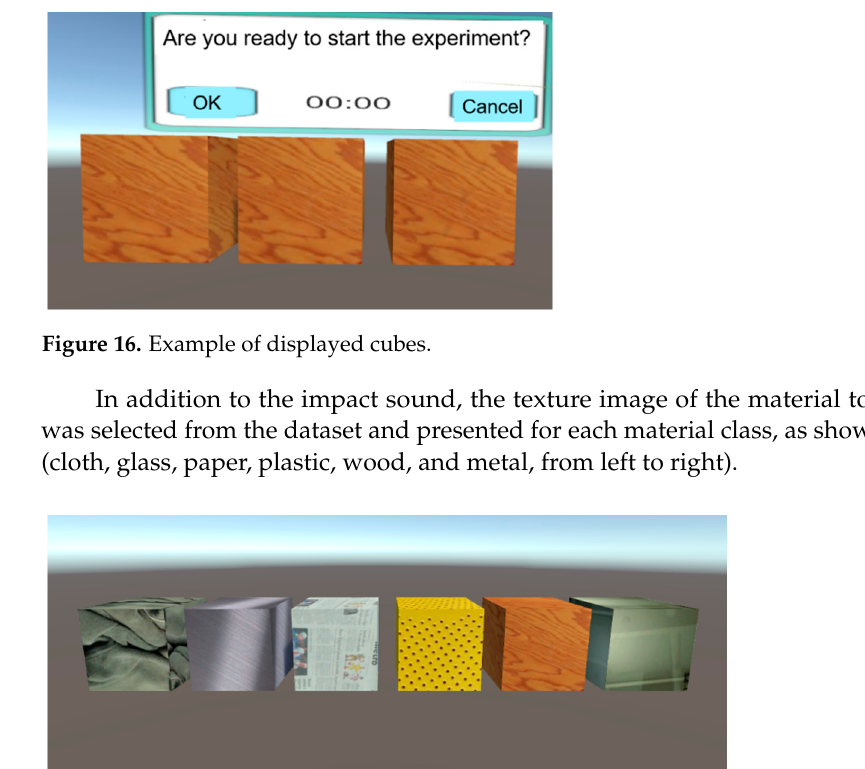
Figure 17. Displaying cubes for each material in VR.